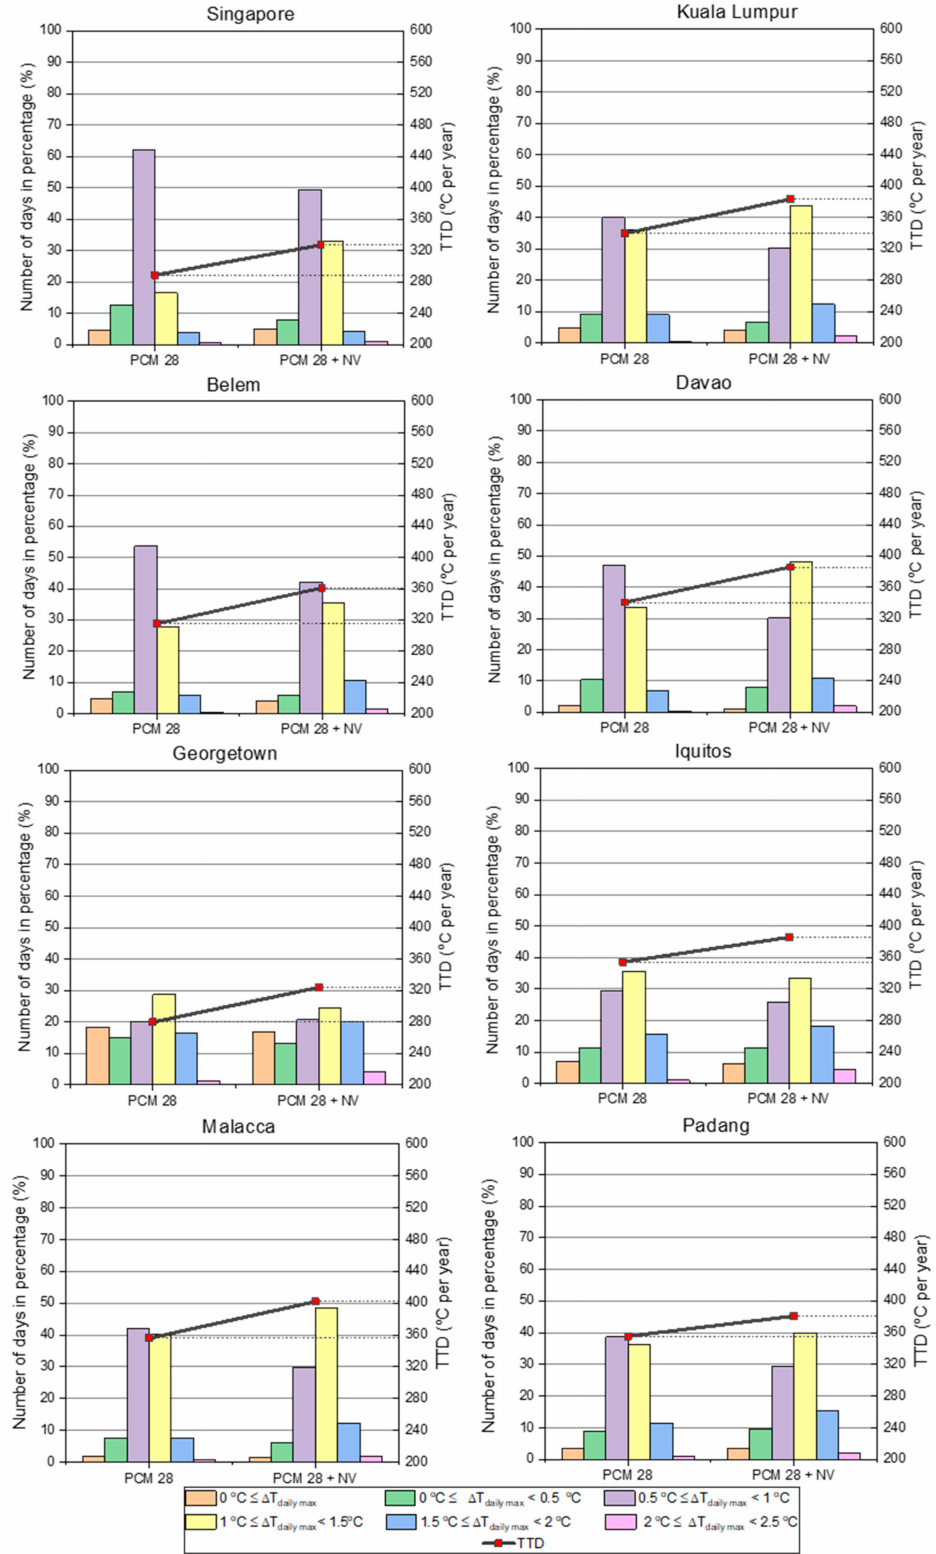
Figure 10. Impact of PCM 28 and PCM 28 + NV on the maximum daily temperature drop and TTD values for all the